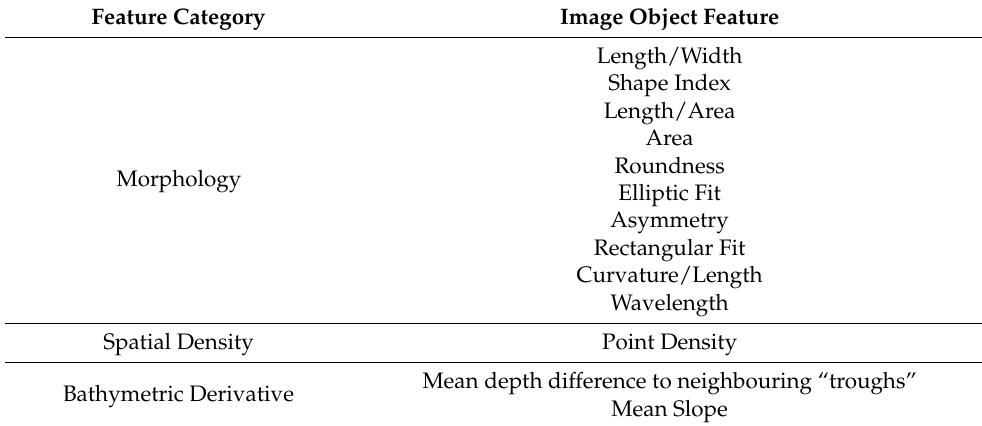
Table 2. Image object features employed in the k-means classification and their respective fea- ture